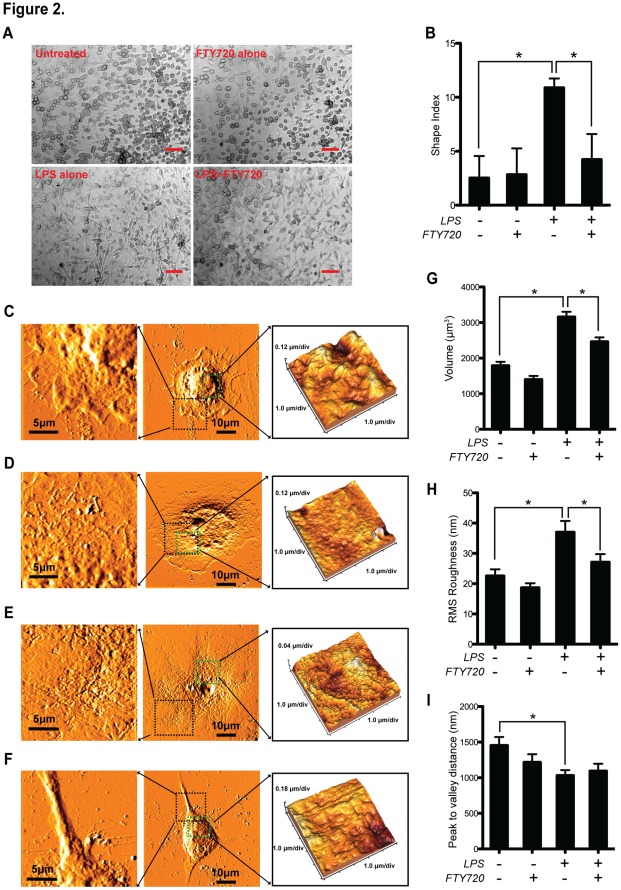
Topographical and morphological changes of BMDCs upon LPS-activation are reversible by FTY720.(A) Morphologies of LPS- and/or FTY720- treated BMDCs. Day 6 BMDCs were exposed to LPS (1 µg/ml) and/or FTY720 (500 nM) for additional 48 h, followed by microscopic observations. Scale bar  = 20 µm. (B) Statistical results on the shape indices of each group. *P<0.05, n = 20 (20 cells randomly selected from high power fields from 3 separate experiments). Atomic force microscope observations on the untreated (C), FTY720 alone (D), LPS alone (E) and LPS+FTY720- (F) treated groups were shown as representative images. Enlarged areas were indicated in squares in dark and green, respectively. The statistical results of the cell volume (G), RMS roughness (H) and peak to valley distance (I) are analyzed and shown in histograms. Data are shown as mean ± SEM. *P<0.05, n = 10 (10 cells randomly selected from 3 separate experiments).